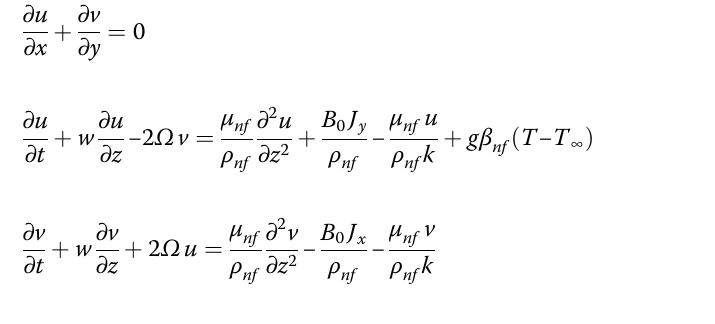
Table 1 Thermo-physical properties of regular fluid and nanoparticles Thermo-physical properties Regular fluid